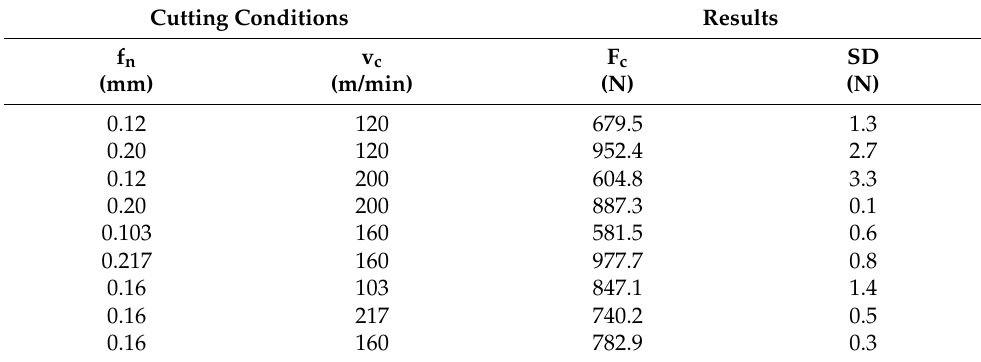
Table 5. Mean cutting force values with standard deviations.